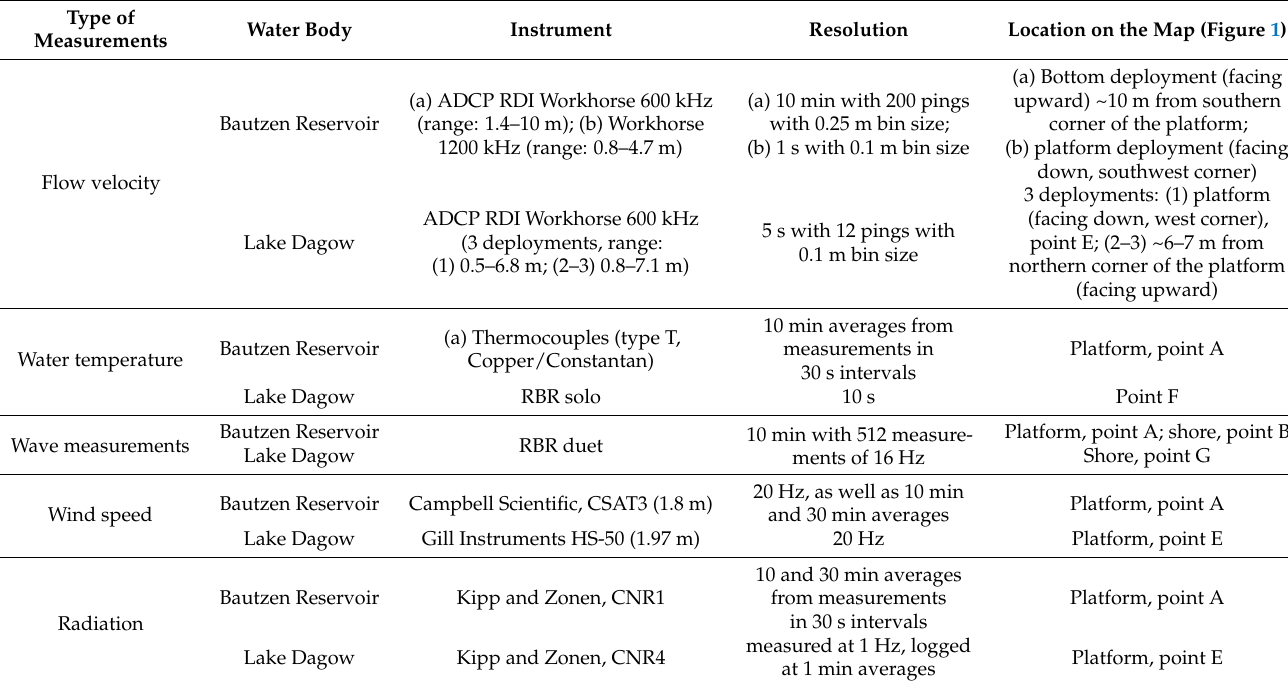
Table 1. Instrumentation and resolution for the water-side and atmospheric measurements conducted in Bautzen Reservoir and Lake